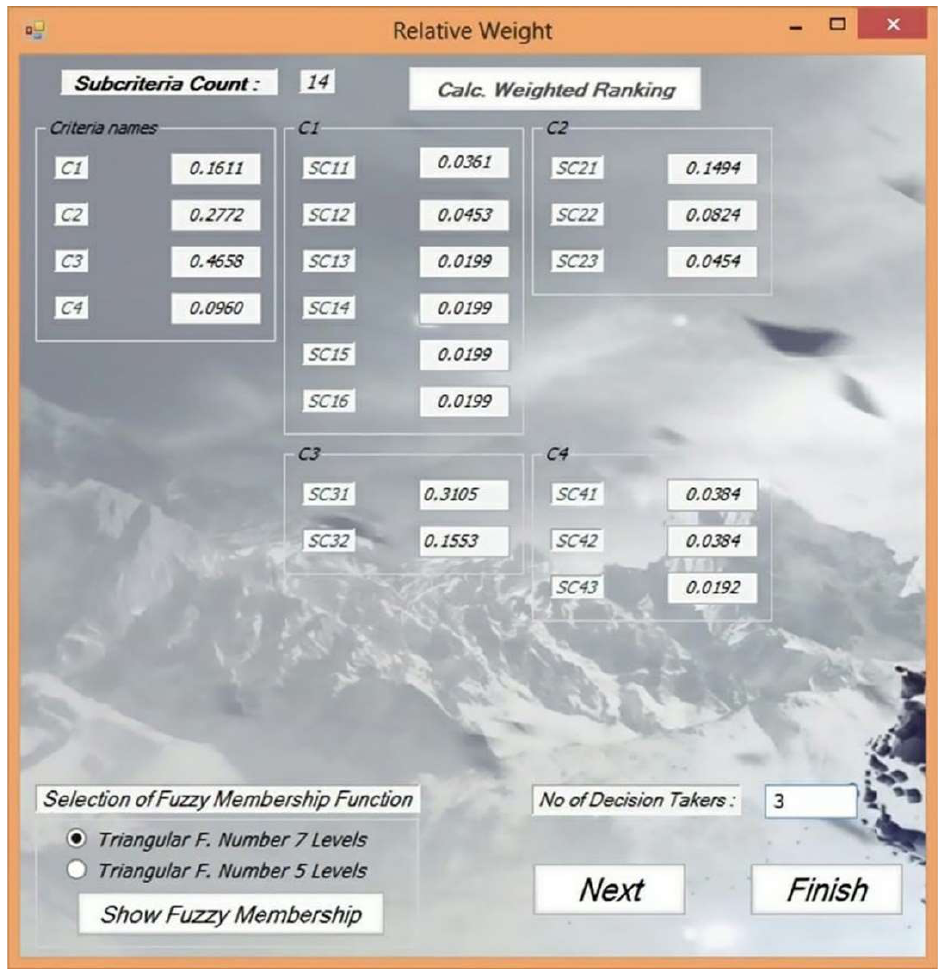
Figure 7. Rel. weights of criteria and sub-criteria.